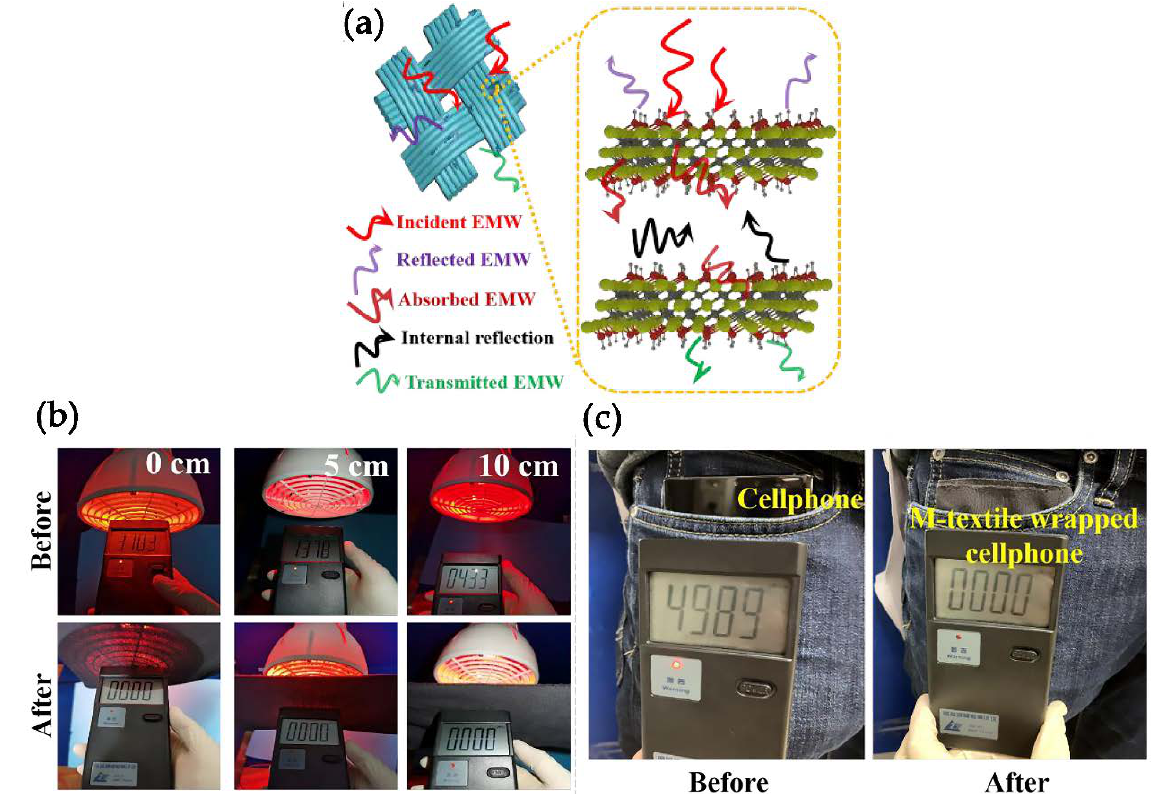
Figure 31. ( a ) Schematic of electromagnetic microwave dissipation in the MXene-decorated textiles. A electromagnetic radiation tester used to check the radiation before and after applying Ti 3 C 2 T x /PET textile on a FIR lamp ( b ) and a cellphone ( c ). Reprinted with permission from [187] 2020 Royal Society of Chemistry.